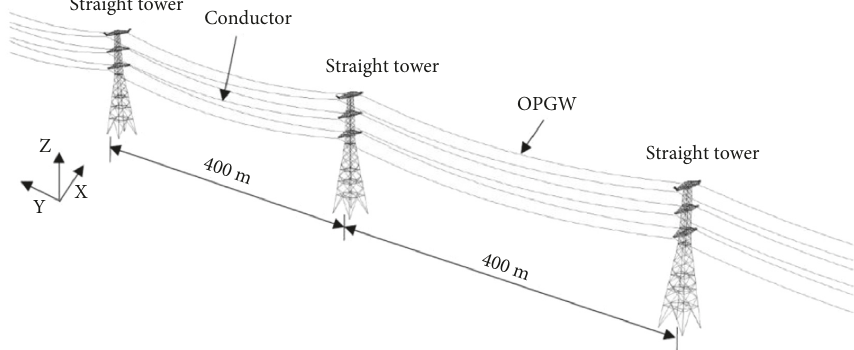
Figure 3: Model of the transmission tower-line system established in SAP2000. Table 2: Specification of conductors and OPGW.